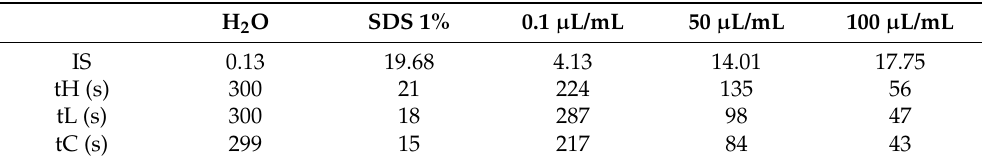
Table 1. Irritation score values for positive controls (SDS 1%), negative controls (distilled water), and nicotine (0.1, 50, and 100 µ